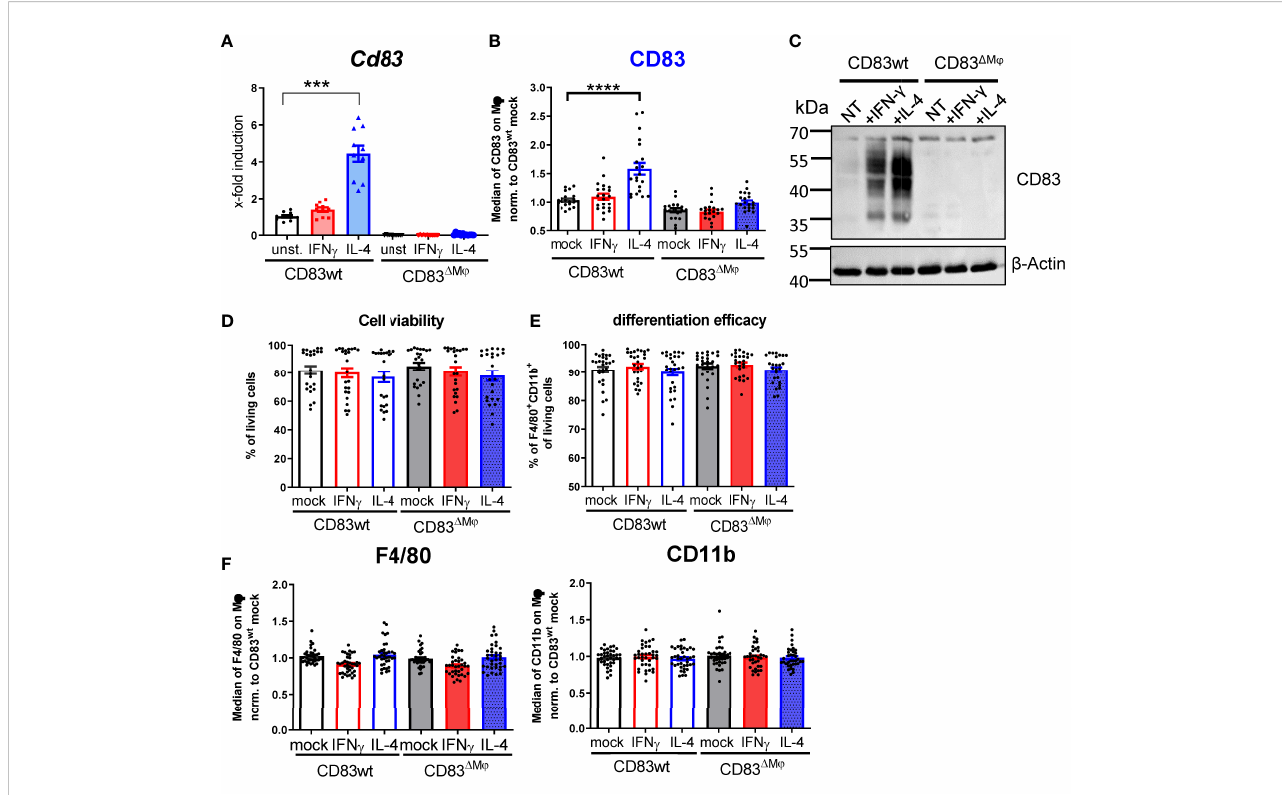
FIGURE 2 Analyses of CD83 de fi cient murine M j . M j were generated from CD83wt or CD83 cKO mice and subsequently stimulated with IFN- g or IL-4 for 16h or left untreated. (A) Cd83 expression levels were determined by qPCR and normalized to CD83wt BMDMs (n = 10). (B) Assessment of CD83 expression levels by fl ow cytometry (n = 20). (C) Assessment of knock-out ef fi ciency in whole cell lysates from mock-, IFN- g or IL-4 stimulated M j by Western blotting. b -actin served as a loading control. See full uncut gels in Supplemental Material (S1) (D) Cell viability assessment using fl ow cytometry (n = 24). (E) Differentiation ef fi cacy assessing the percentage of F4/80 + CD11b + cells by fl ow cytometry, representing the M j population (n ≥ 24). (F) Expression levels of F4/80 and CD11b within the M j population (n ≥ 40). The gating strategy for the M j population is depicted in Supplementary Figure 2. Statistical analyses were performed by One-way ANOVA or the appropriate corresponding non-parametric test. Data are represented as mean ± SEM. Experiments were performed at least three times. ***p<0.001; **** p< 0.0001. The absence of asterisks indicates that there is no statistical signi fi